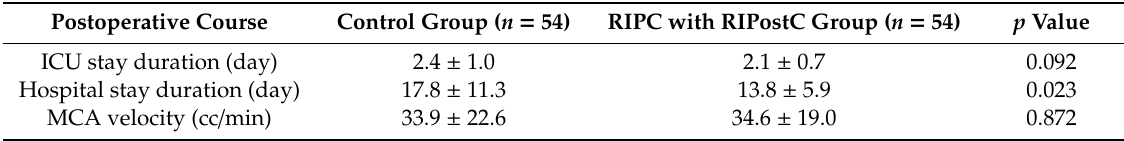
Table 2. Duration of hospital stay and postanastomosis MCA velocity.